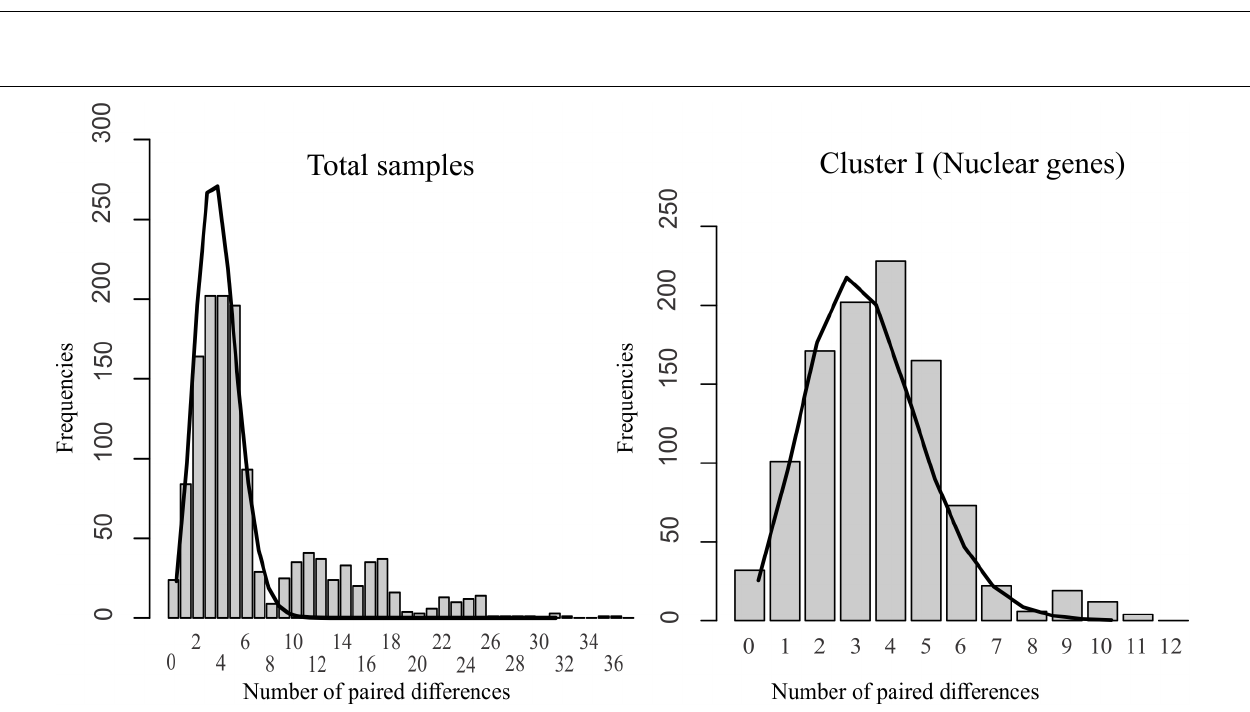
FIGURE 4 | Distribution mismatch for genetic group I determined by BAPS and the total sample of S. reilianum using the ITS region, β -tubulin, and Eap1 nuclear genes. Gray bars represent the observed values; the black line represents the expected distribution under a hypothesis of population expansion.